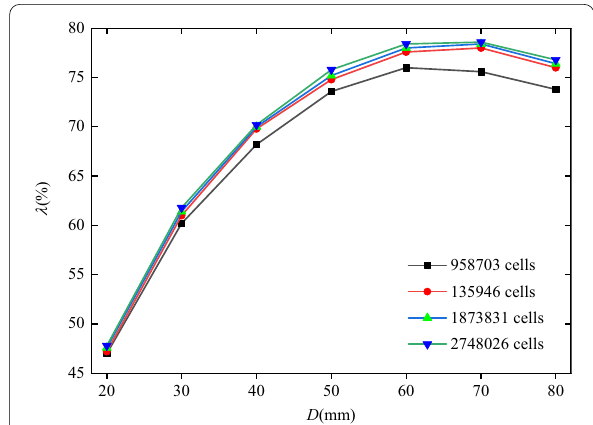
Figure 3 Coring rates under different grid models